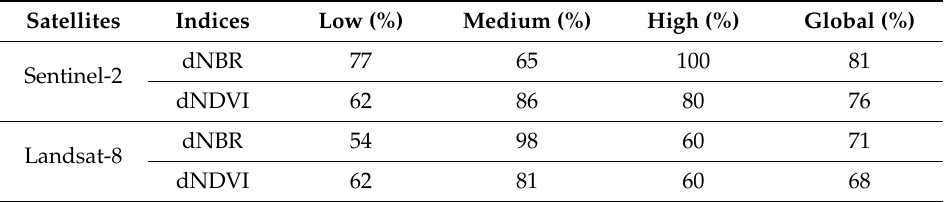
Table 5. Success accuracy (%) for each field severity class in Pontevedra fire.